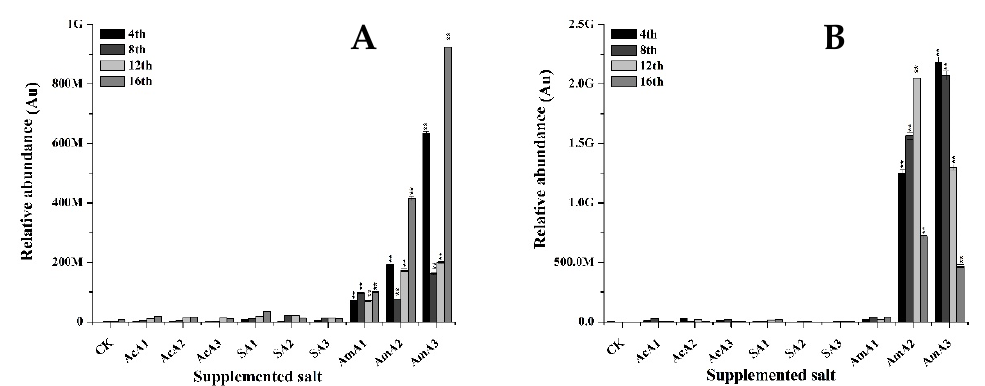
Figure 8. Monascorubramine value of M. ruber M7 grown over PDA spiked with acetic acid, sodium acetate and ammonium acetate at di ff erent concentrations. Acetic acid: AcA1: 0.1%, AcA2: 0.25%, AcA3: 0.5%; Sodium acetate: SA1: 0.1%, SA2: 0.25%, SA3: 0.5%; Ammonium acetate: AmA1: